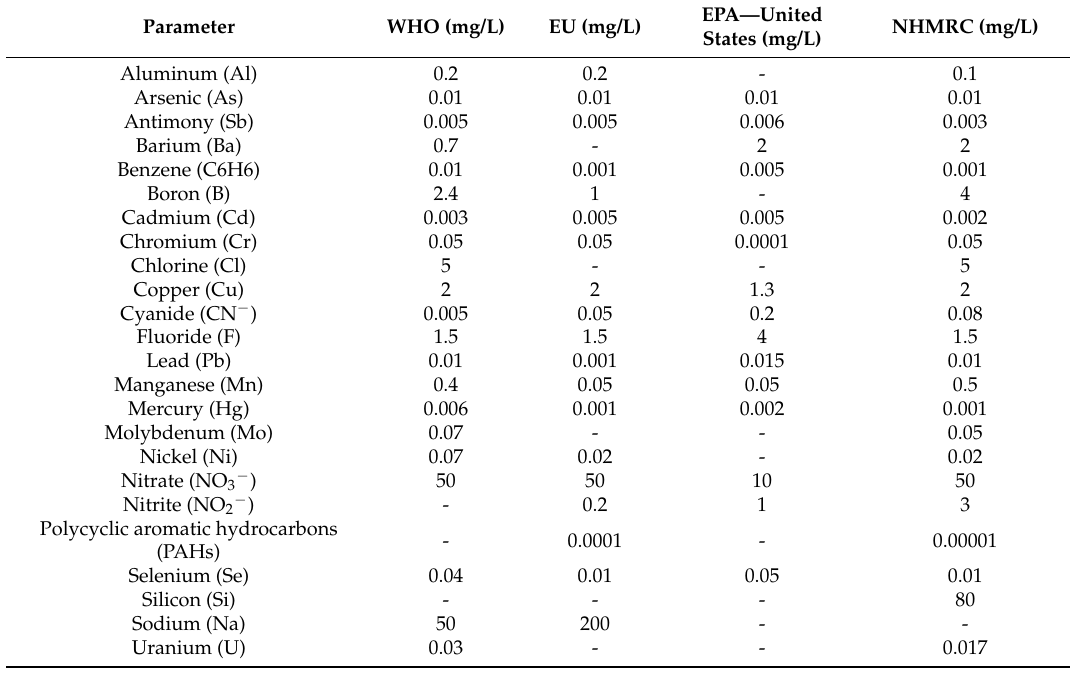
Figure 2. Mechanisms of alteration in UDW caused by CO 2. Table 1. Maximum acceptable concentrations (MACs) of various chemical parameters reported by the World Health Organization (WHO), European Union (EU), Environmental Protection Agency (EPA), and Australian Government National Health and Medical Research Council (NHMRC).